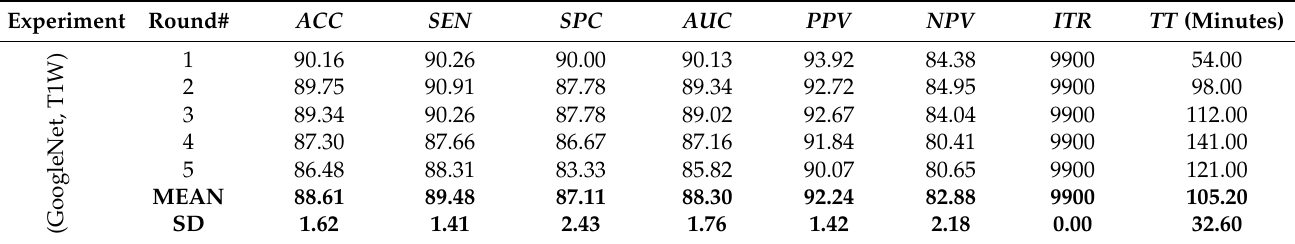
Table A6. Test results of five-folds of experiment (GoogleNet, T1W).